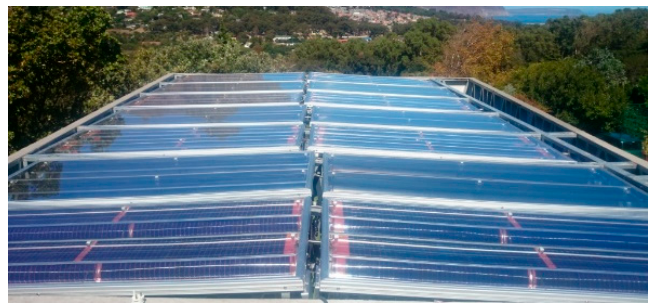
Figure 3. Prototype installation consisting of eight C-PVT collectors (closer) and six concentrating thermal collectors